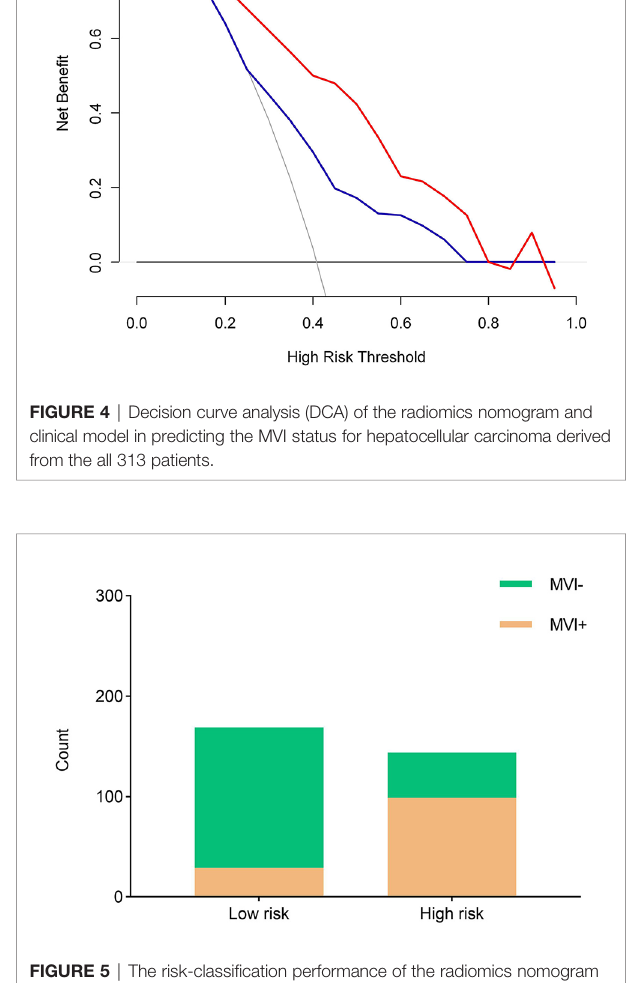
tumor size, AFP levels, PVP, and DP radiomics scores were the